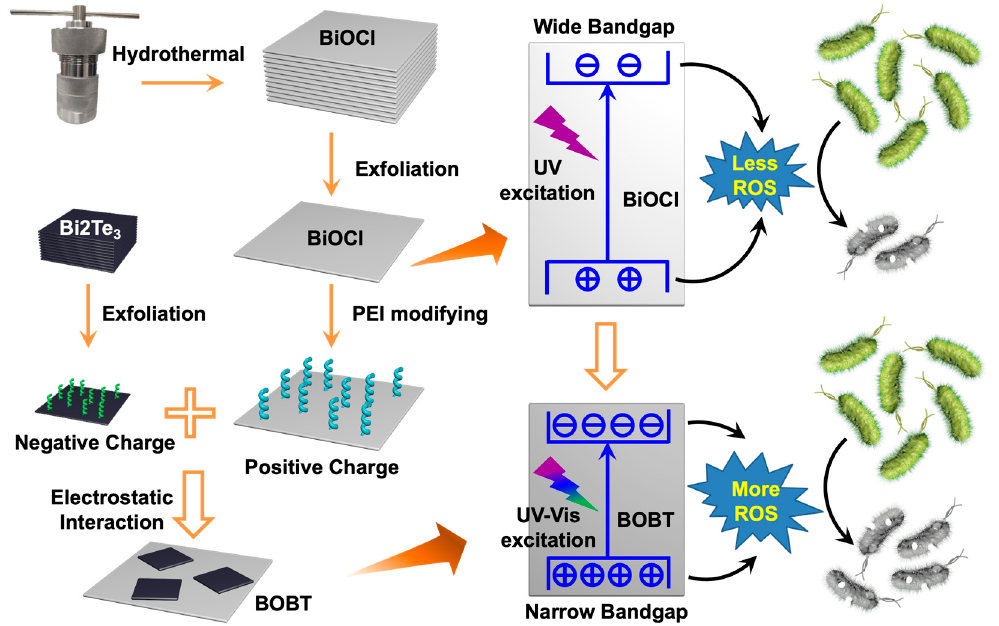
Figure 7. Antibacterial activity of Bi 2 Te 3 -functionalized BiOCl NMs. Reproduced with permission from Ref. [104], 2021, Royal Society of Chemistry.